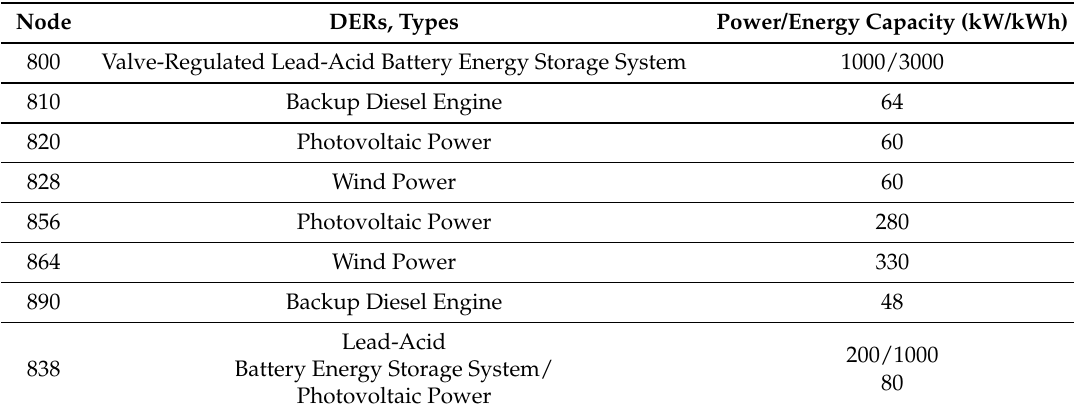
Table 5. Node location, type and distributed energy resources (DER) nominal power an in [26]. Node DERs,